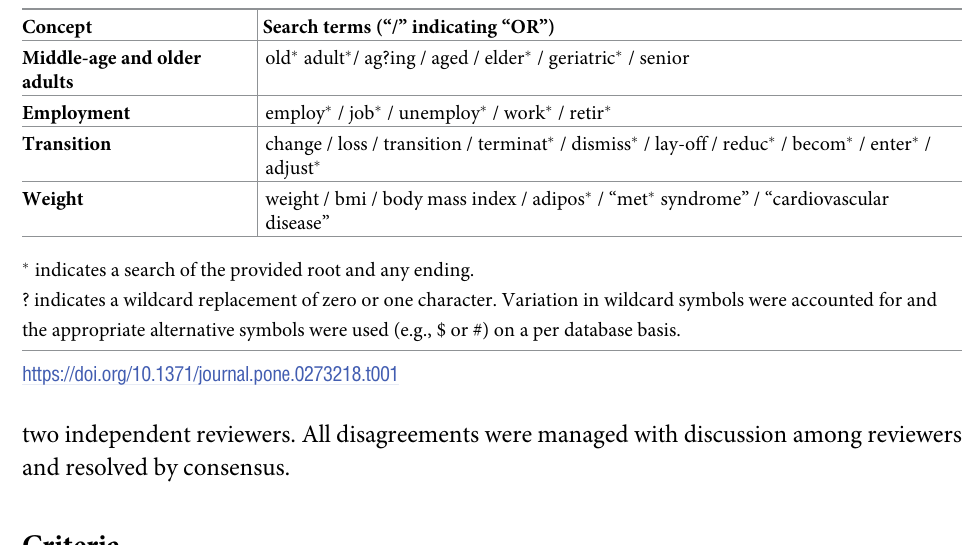
Table 1. Search terms used in literature